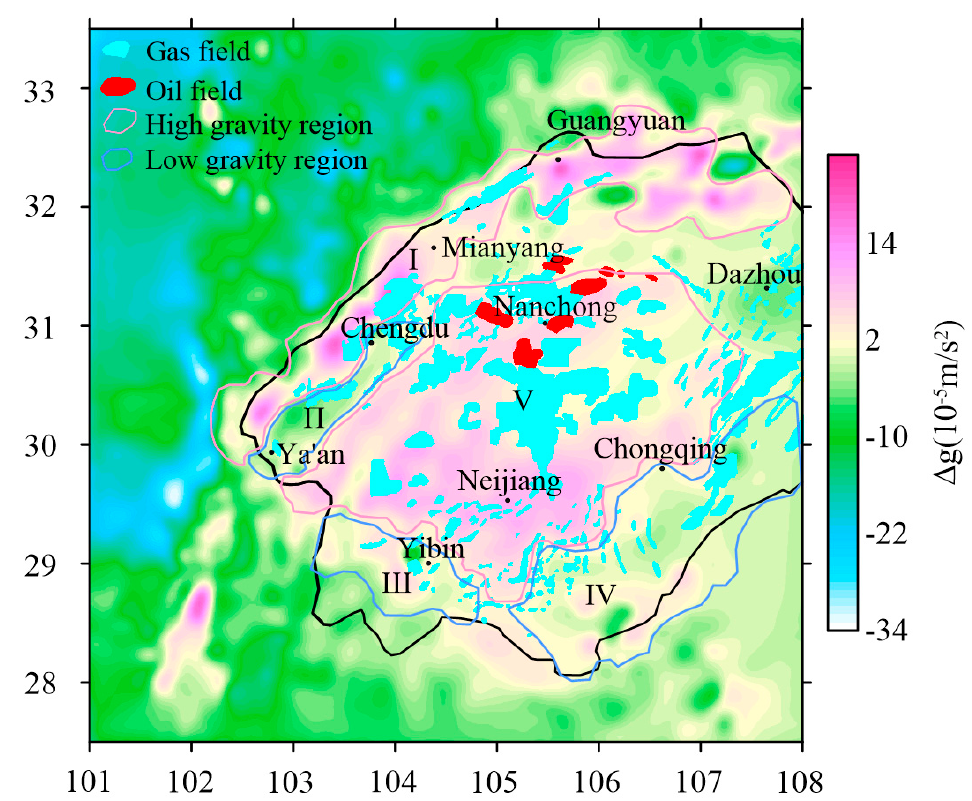
Figure 3. Map of the residual gravity anomaly in central and western Sichuan Basin. (I: high gravity value in Longmenshan–Micangshan area; II: the low–value gravity area in Ya ’an; III: the low–value gravity area in Yibin; IV: the low–value gravity area in Huayingshan–Qiyueshan; V: high–value gravity in Neijiang–Nanchong area).